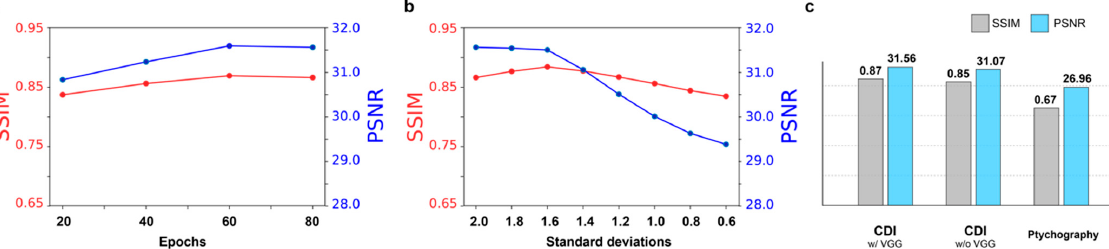
Figure 3. The performance evaluation of the model with the SSIM and PSNR index. ( a ) Both indices are stabilized at epoch 80. ( b ) The GAN model trained with the images blurred by the Gaussian blur kernel of the standard deviation 2 is evaluated when it is applied to the different levels of blurriness. ( c ) The comparison of model performance when the perceptual loss is included and not considered.